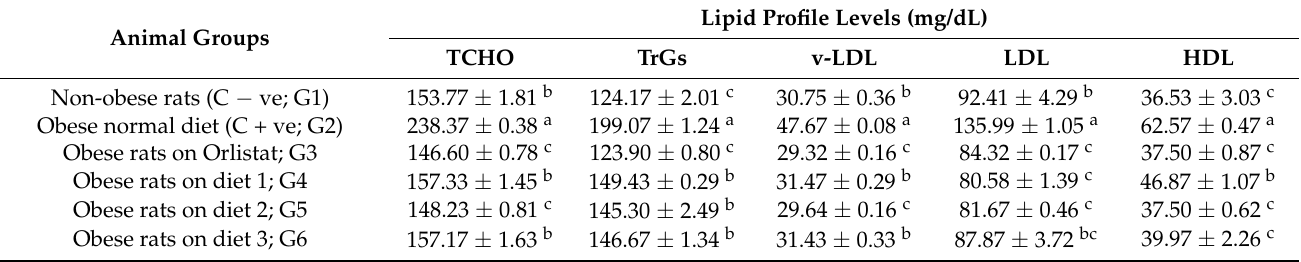
Table 4. Effects of biscuits supplemented at different DF levels on lipid profiles of obese